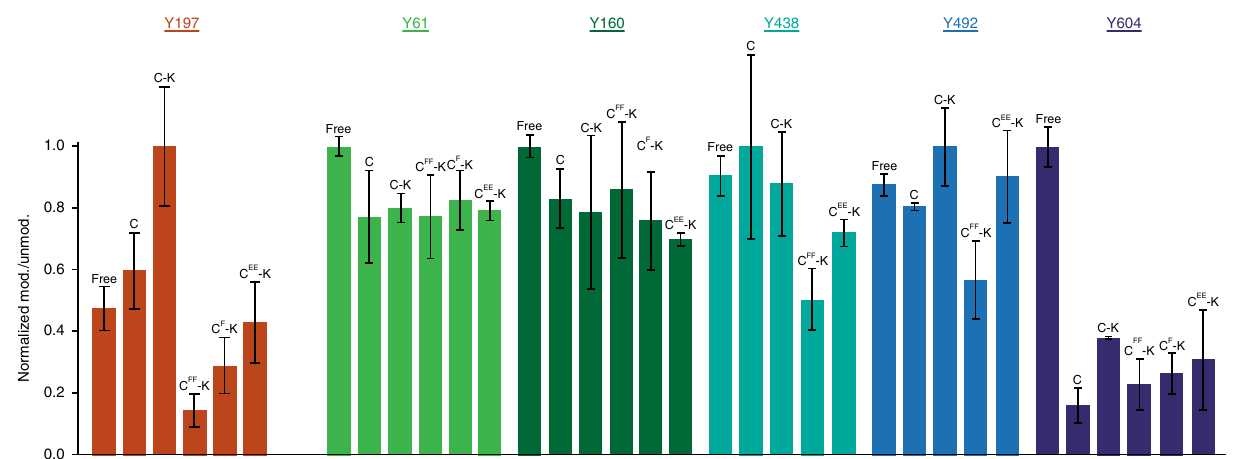
Fig. 5 Phosphorylation of Hsp90 in the context of in vitro-assembled complexes. Mass spectrometry intensity ratios of Yes-modi fi ed Hsp90 α peptides over the corresponding unmodi fi ed peptides for positions Y61, Y160, Y197, Y438, Y492, and Y604. Ratios are normalized to the highest-detected phosphorylation levels among fi ve different liganded states of Hsp90 α : free, in a binary complex with wild-type Cdc37 (C), or in a ternary complex with bRaf and Cdc37 variants (wild type = C-K, doubly non-phosphorylatable = C FF -K, singly non-phosphorylatable = C F -K, and double phosphomimetic = C EE -K). Error bars are de fi ned as s.d., over two replicates